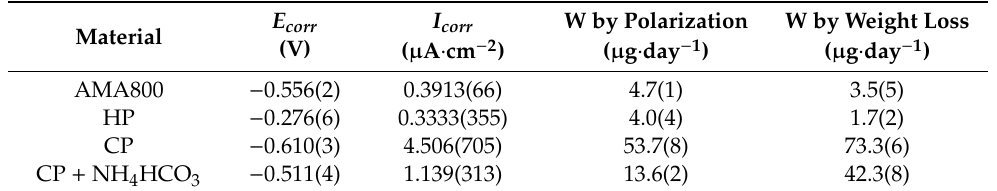
Table 4. Estimated from Tafel extrapolation corrosion potential ( E corr ) and current ( I corr ) with calculated weight loss from Faraday law (W by polarization) and after 14 days immersing in Ringer solution environment (W by weight loss) of Ti23Mo alloys obtained by di ff erent processing approaches.